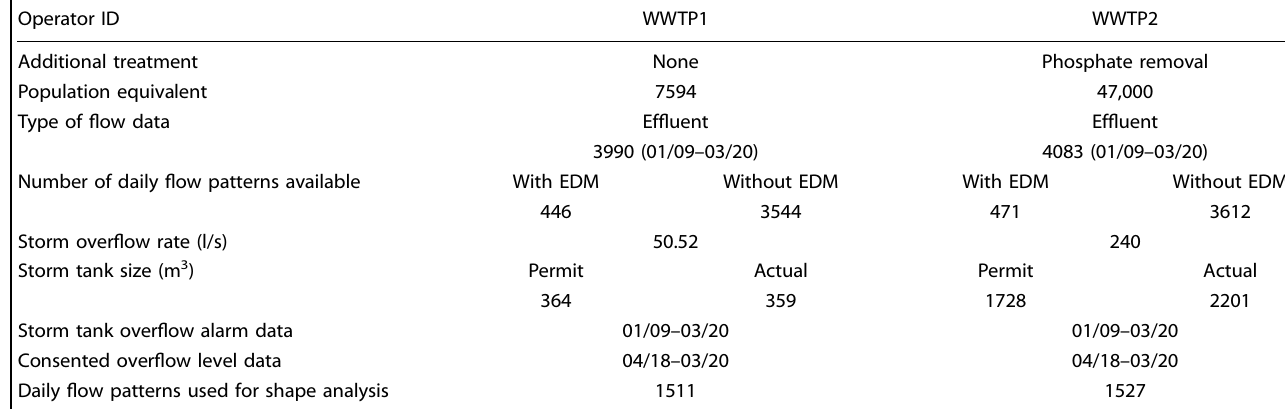
Table 1. Metadata for WWTP1 and